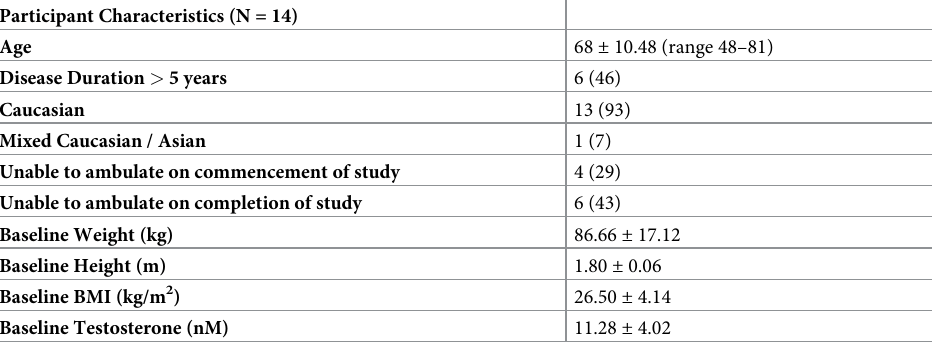
Table 1. Participant characteristics at